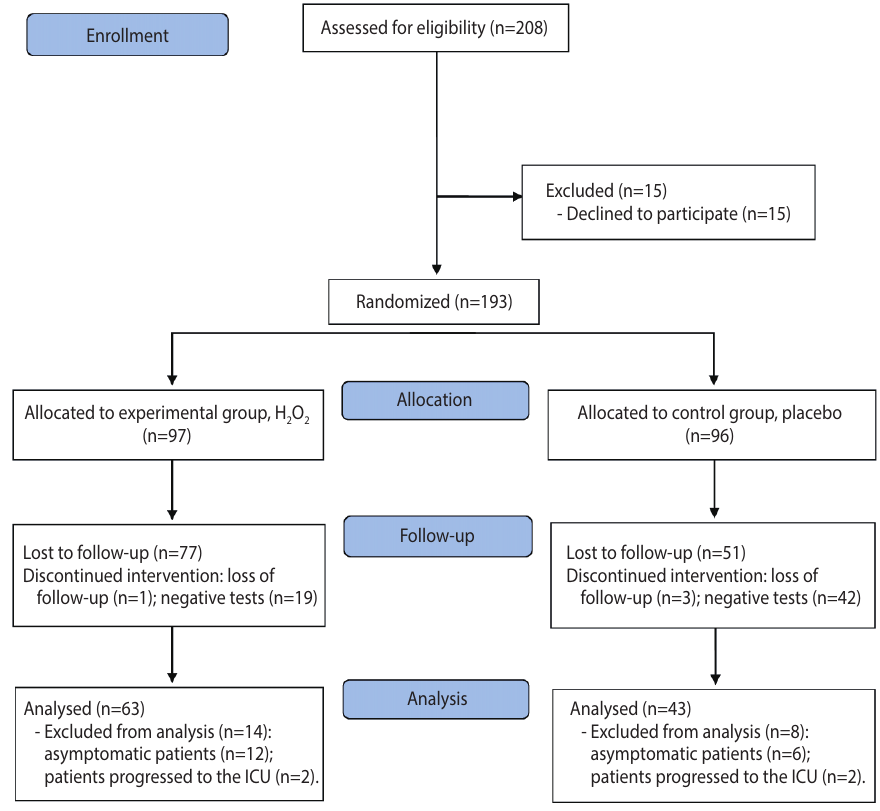
Figure 1. CONSORT (Consolidated Standards of Reporting Trials) 2010 flow diagram. H 2 O 2 , hydrogen peroxide; ICU, intensive care